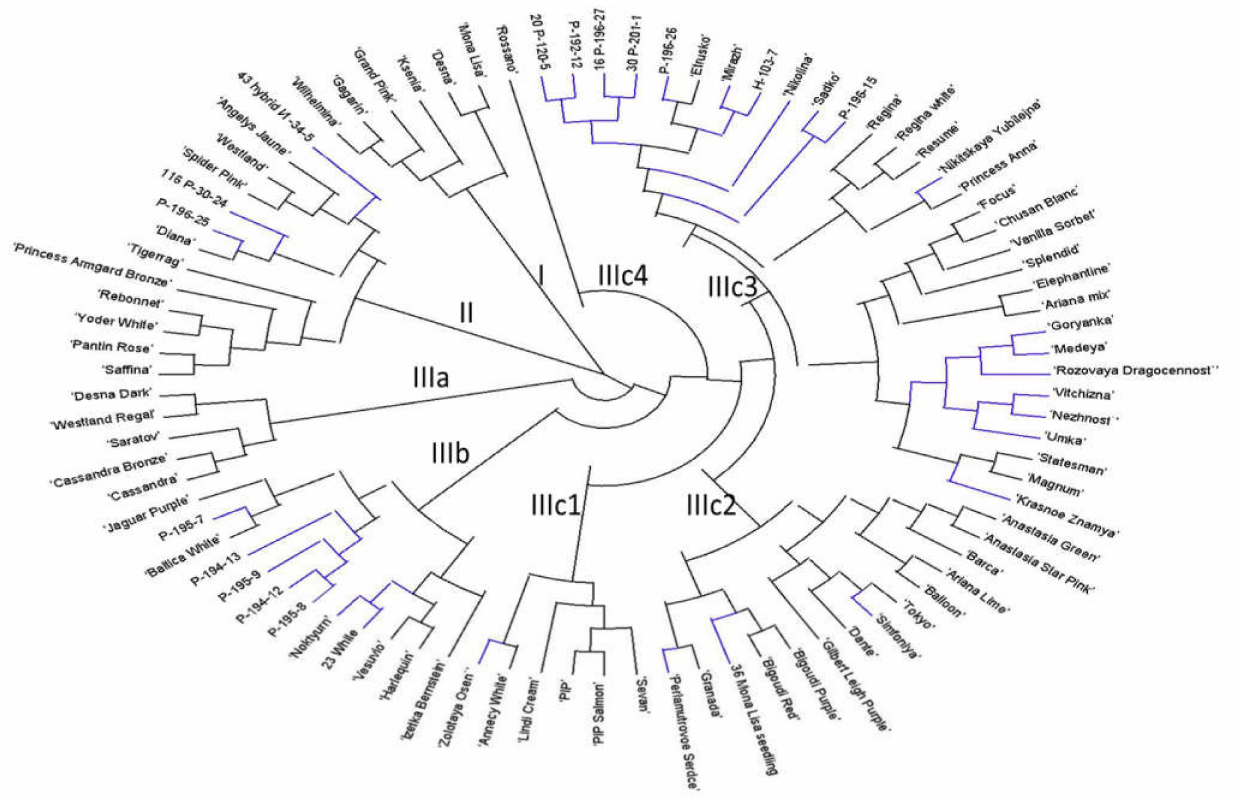
Figure 2. Genetic relationships among 95 chrysanthemum genotypes calculated by SSR, SCoT, and ISSR data. The letters on the picture indicate the related brunches. Blue branches—genotypes of the Russian breeding, black branches—genotypes of the foreign